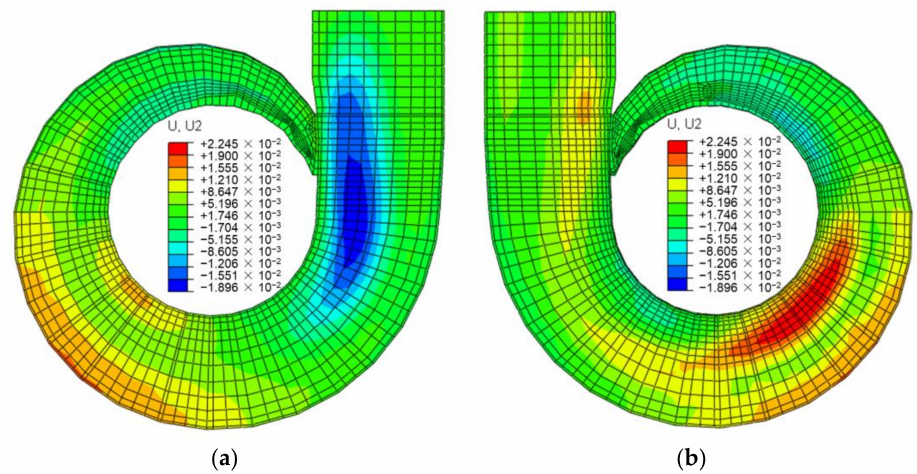
Figure 15. Vertical displacement of the SSC (pressurized case) (m): ( a ) top view; ( b ) bottom